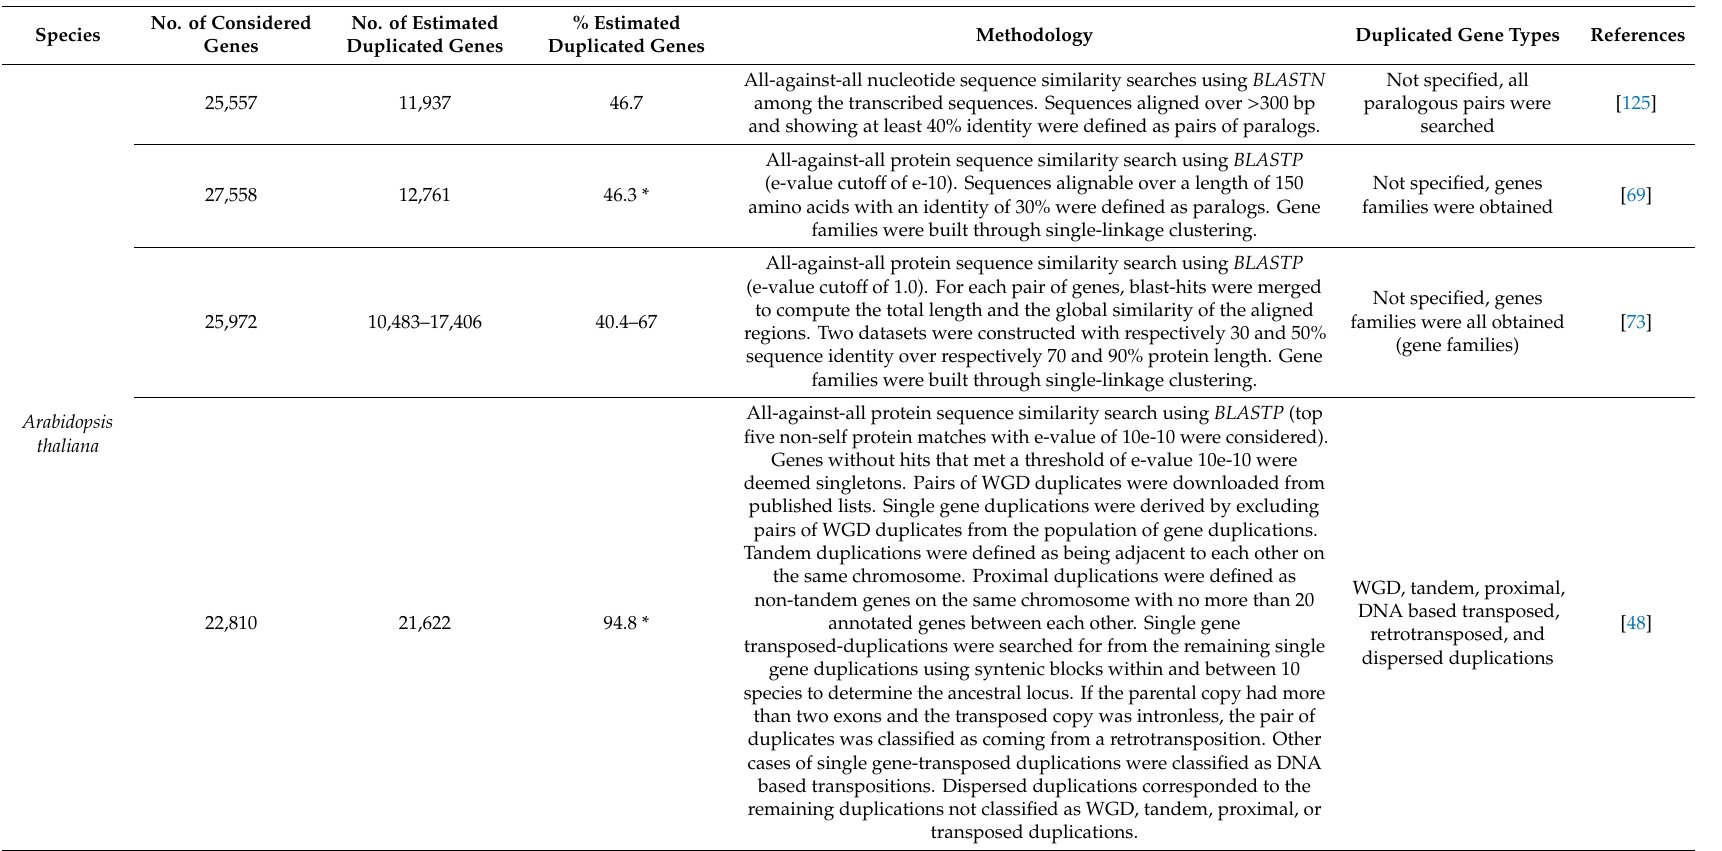
Table 1. Estimation of the amount of duplicated genes in di ff erent